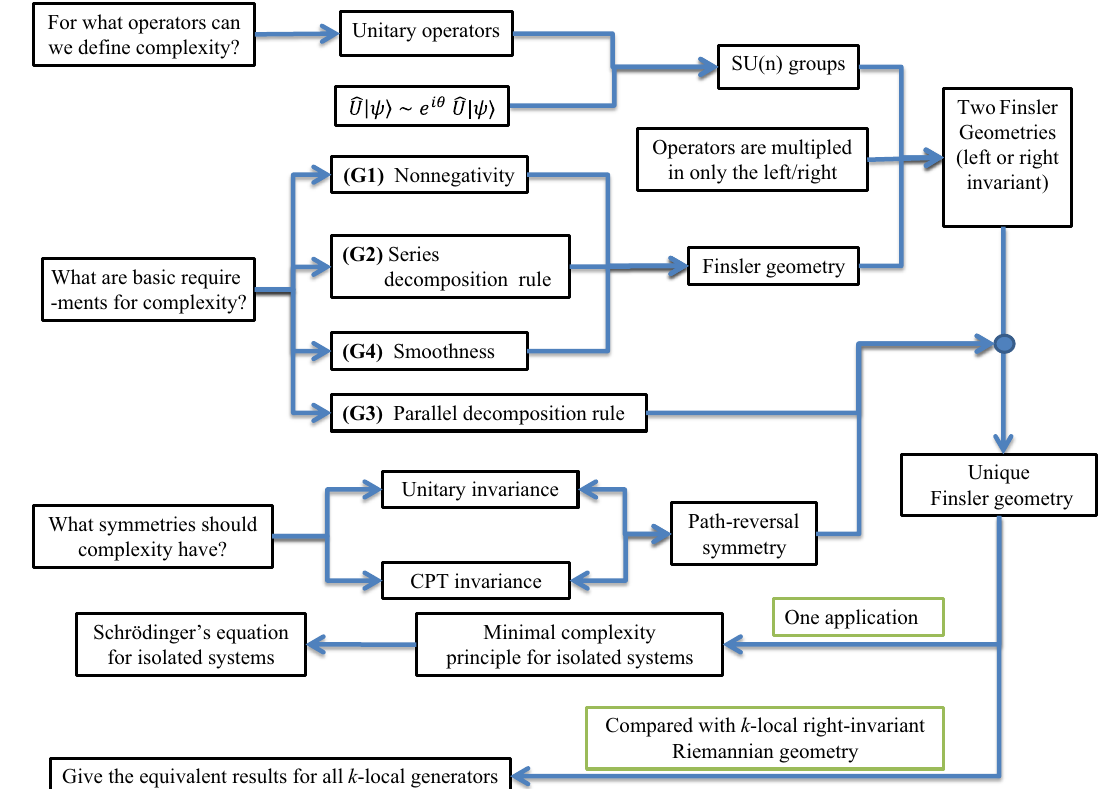
Fig. 1 The logical flows of this paper. By answering three basic ques- tions at the far left side we show that the complexity geometry is deter- mined by a unique bi-invariant Finsler geometry. As an application of our formalism, we show that the Schrödinger’s equation for isolated